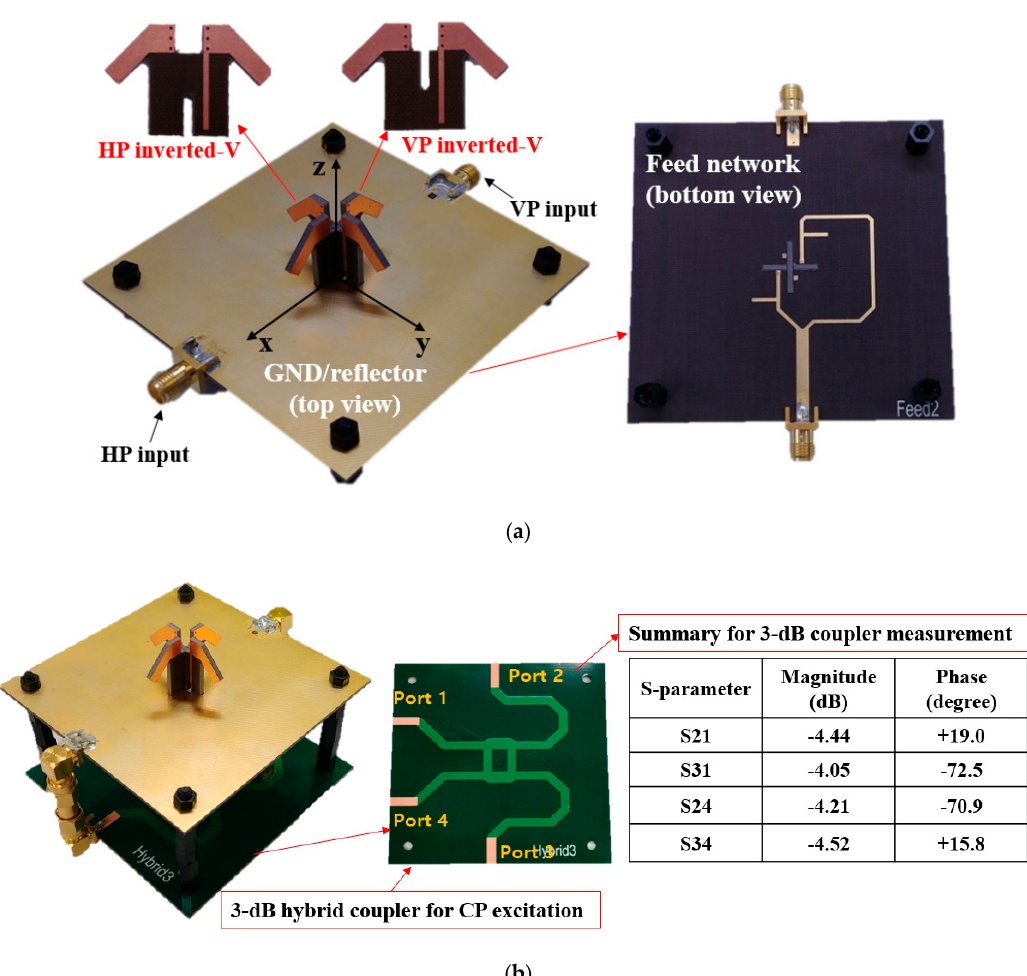
(RHCP) and the left-hand circular polarization (LHCP) test with an additional 3-dB hybrid coupler.